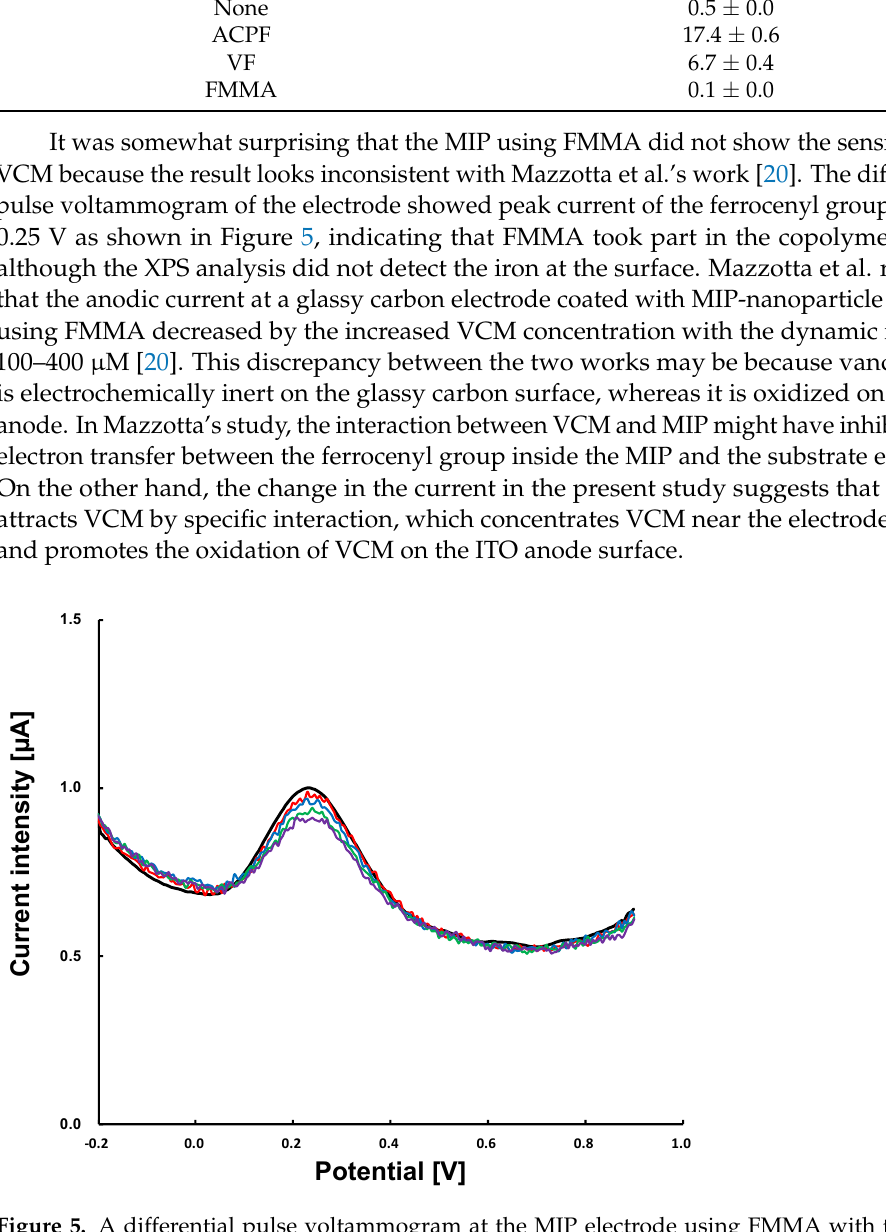
Figure 5. A differential pulse voltammogram at the MIP electrode using FMMA with the VCM concentration of 0 (black), 10 (red), 20 (blue), 30 (green) and 40 (purple) μM. (The peak current decreased with the number of measurements, independent of the VCM concentration).